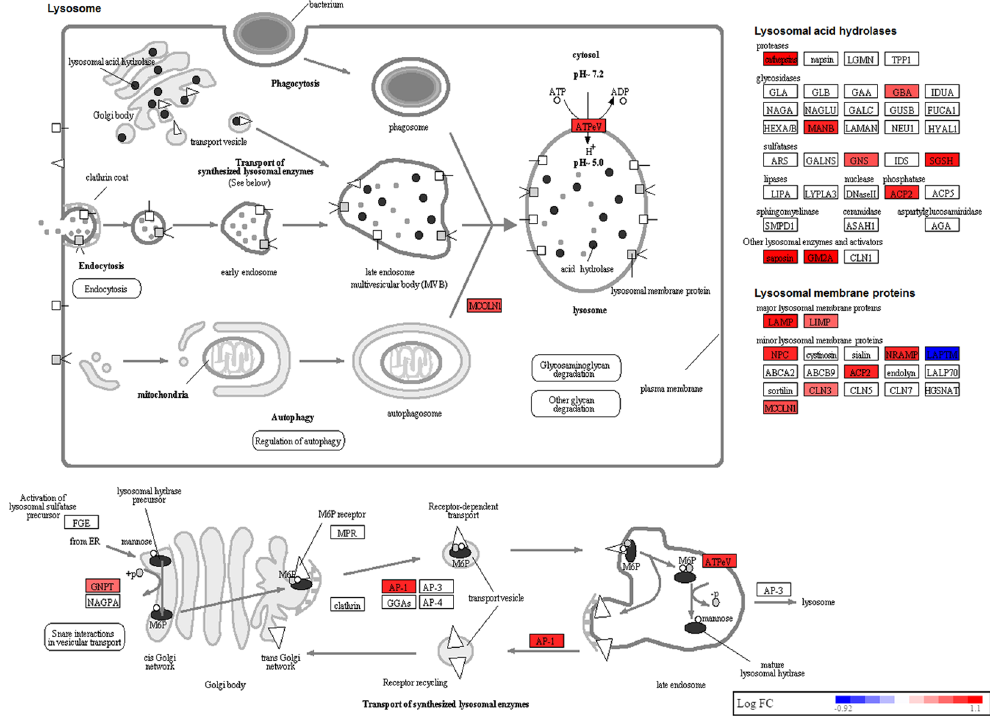
Figure 4. Upregulation of genes involved in lysosomal pathway in sarcoidosis monocytes. Graphic illustration of pathway analysis of DE (log 2 -fold change with FDR < 0.05) genes related to lysosome in sarcoidosis monocytes. The pathway diagram is overlaid with the computed perturbation of each gene. The perturbation accounts both for the gene’s measured fold changes and for accumulated perturbation propagated from any upstream genes (accumulation). The color intensity corresponds to the level of upregulation (red) or downregulation (blue) of the DE genes in sarcoidosis monocytes versus healthy monocytes. Note: Various genes involved in lysosomal membrane proteins and acid hydrolases were upregulated except LAPTM4B gene which was